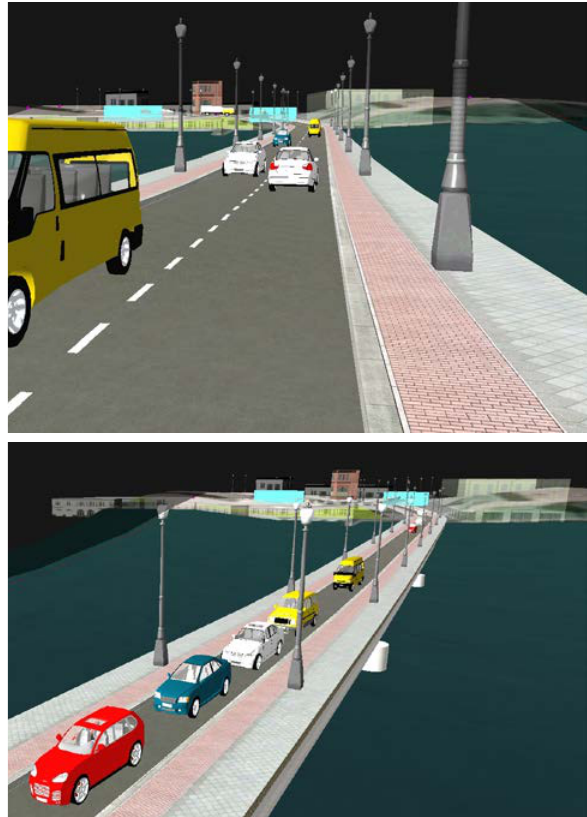
Figure 10. Some images of the simulation with 1 (bottom) and 2 lanes (top). The 3D model of the bridge is not the one generated from laser point clouds, as a detailed geometric model was not necessary for such traffic analysis. A simplified model of the bridge was generated via parametric modelling, changing in an automatic way the number of